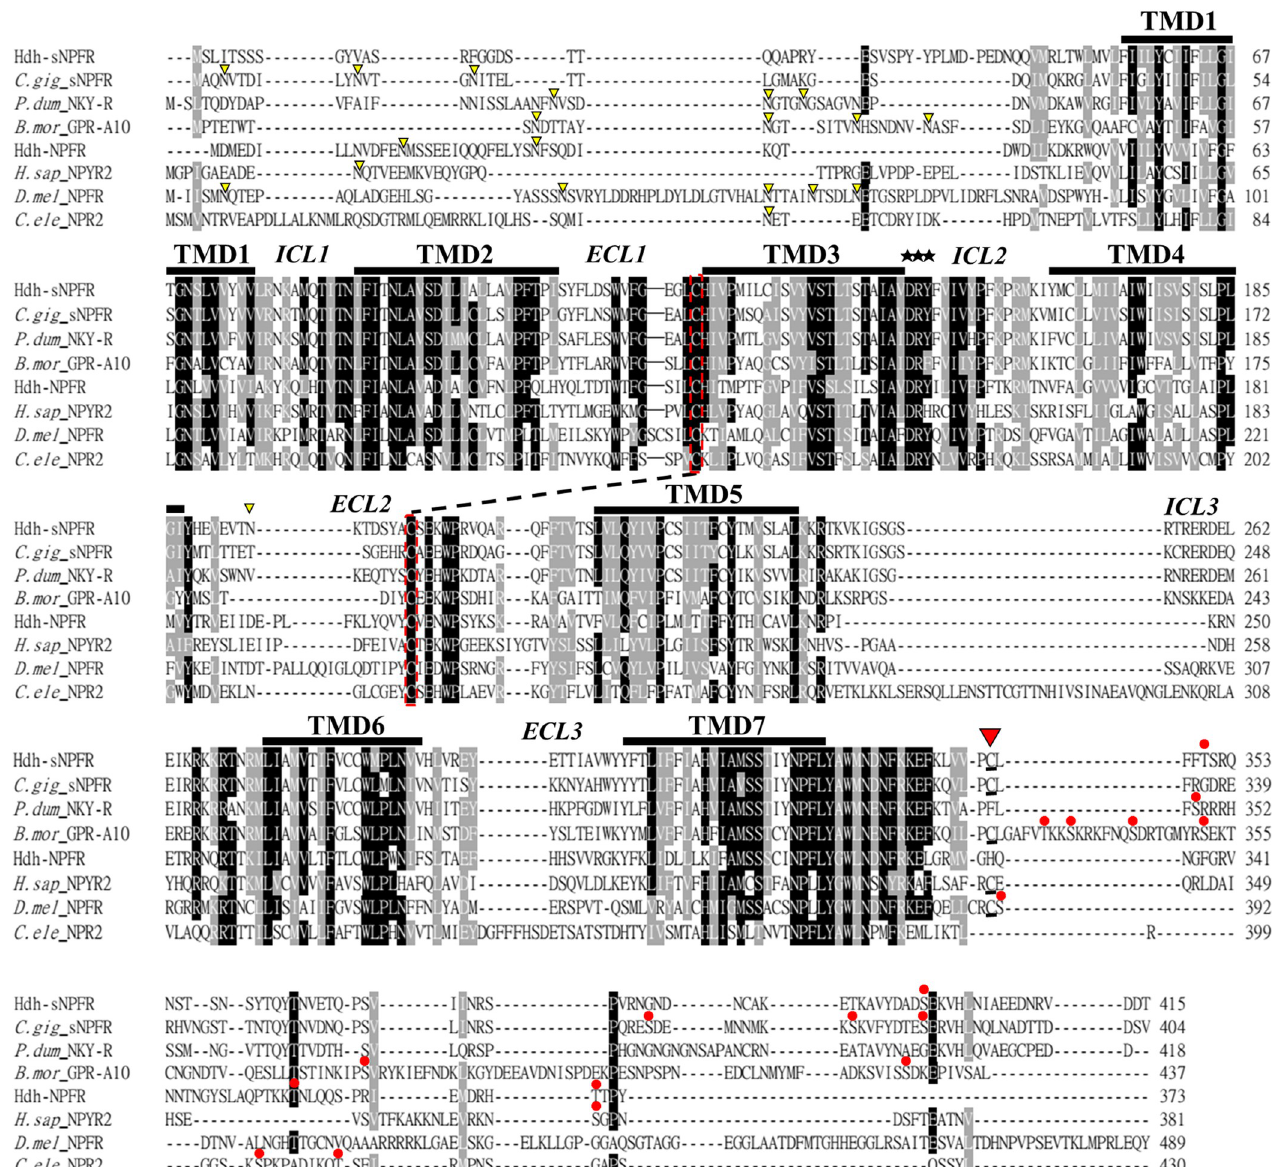
Fig 3. Amino acid sequence alignment of sNPFR-related receptors. The predicted seven transmembrane domains (TMD1–7) with three extracellular and intracellular loops (ECL1–3 and ICL1–3) are indicated on the aligned sequences. Identical and highly conserved residues ( > 70%) are shaded in black and gray, respectively. Potential N-linked glycosylation sites, the characteristic E/DRY/F sequence of rhodopsin-like GPCR, and consensus PKC and PKA phosphorylation sites are denoted with yellow arrowheads, black stars, and red dots on the amino acids, respectively. A putative disulfide bridge connecting ECL1 and ECL2 and a presumed palmitoylation-linked Cys-residue in the C-terminal intracellular domain are indicated by a dotted line and red arrowhead, respectively. Sequence abbreviations are listed in S2